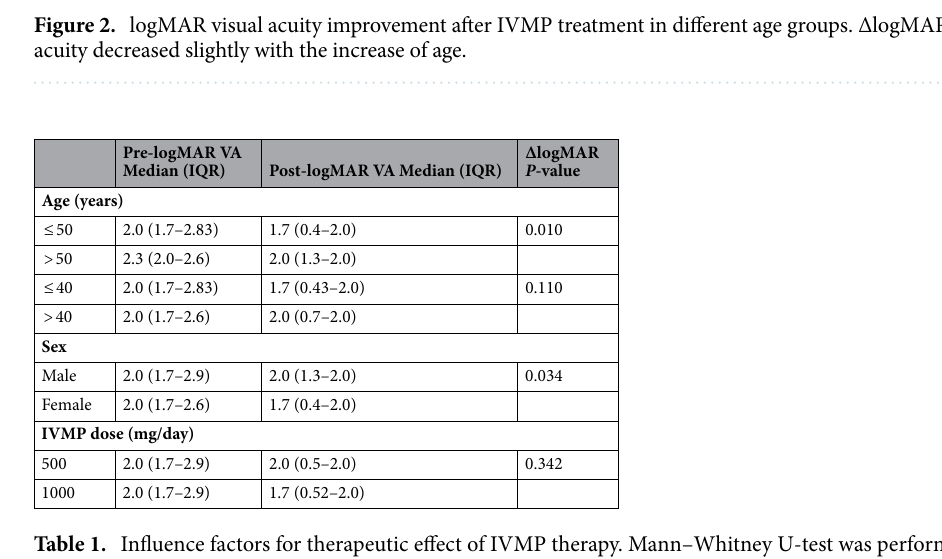
Table 1. Influence factors for therapeutic effect of IVMP therapy. Mann–Whitney U-test was performed in all comparisons. IVMP intravenous methylprednisolone pulse, IQR interquartile range.